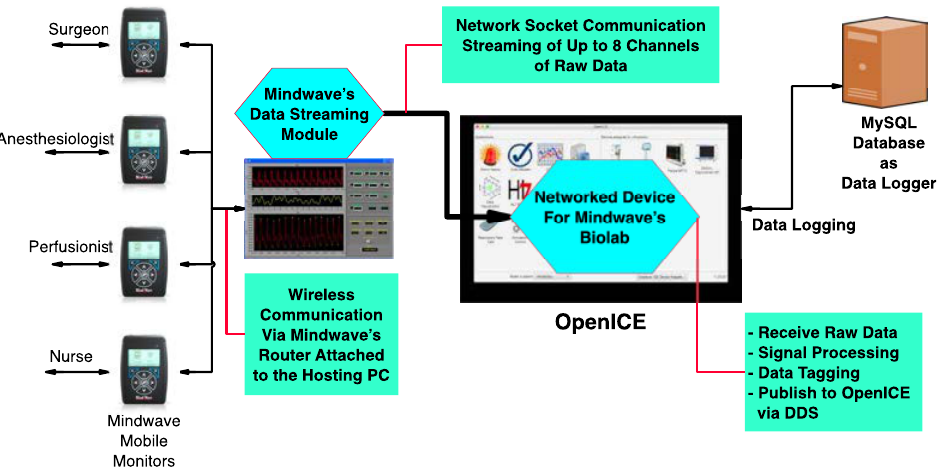
Figure 1. COR-ICE Figure 1. COR - ICE Architecture .